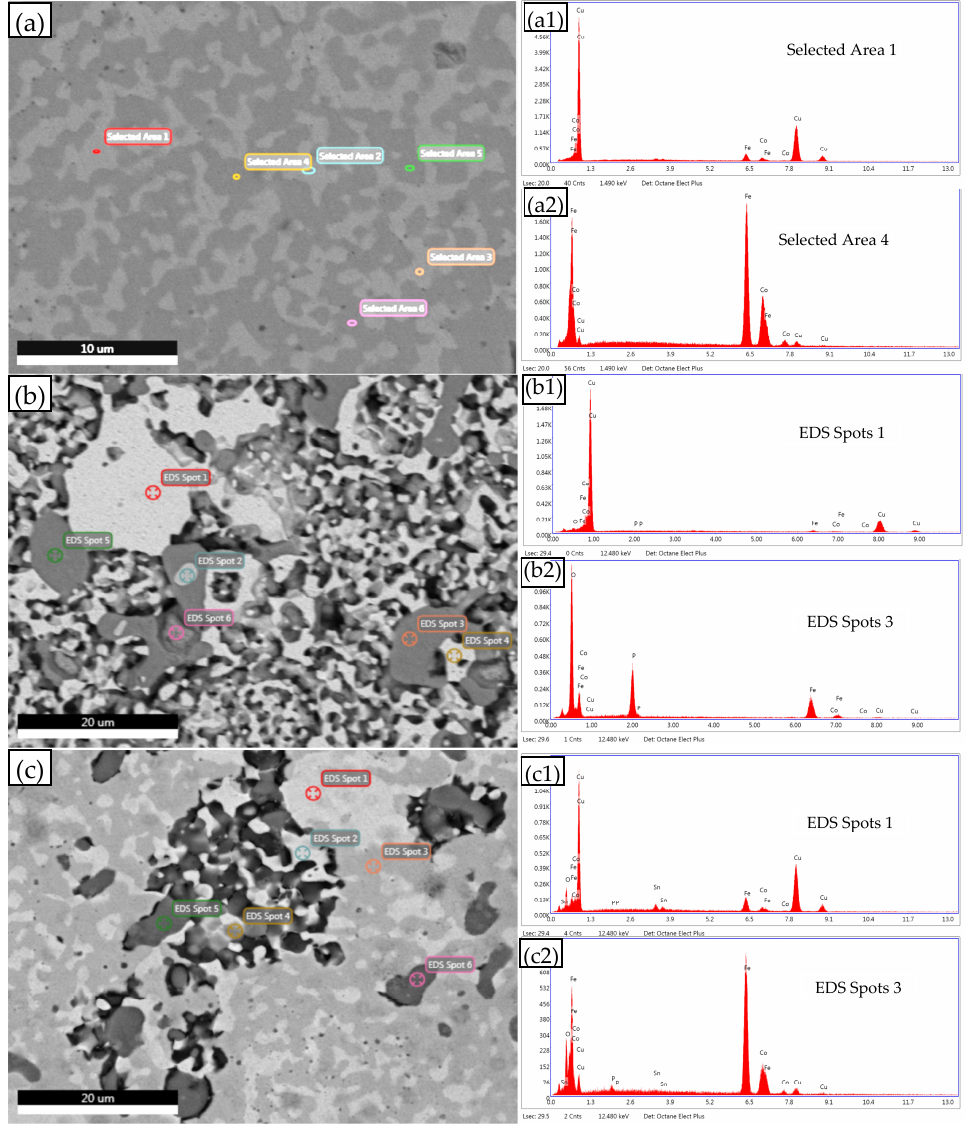
Figure 6. EDS analysis with SEM of Fe ‐ Co ‐ Cu alloy ( a ) before electrochemical test without Cu ‐ Sn addition, ( b ) after electrochemical test without Cu ‐ Sn addition, and ( c ) after electrochemical test with 11 wt.% Cu ‐ Sn addition. X ‐ ray EDS spectrum of selected area ( a1 ) 1 and ( a2 ) 4 in ( a ), spots ( b1 ) 1 and ( b2 ) 3 in ( b ), spots ( c1 ) 1 and ( c2 ) 3 in ( c ).